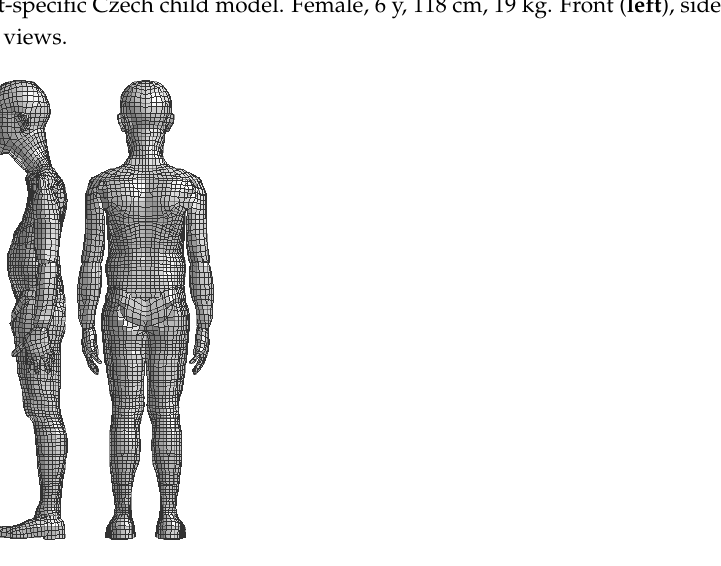
Figure 10. Subject-specific Czech adolescent model. Male, 10 y, 144 cm, 35 kg. Front ( left ), side ( middle ), and back ( right ) views.